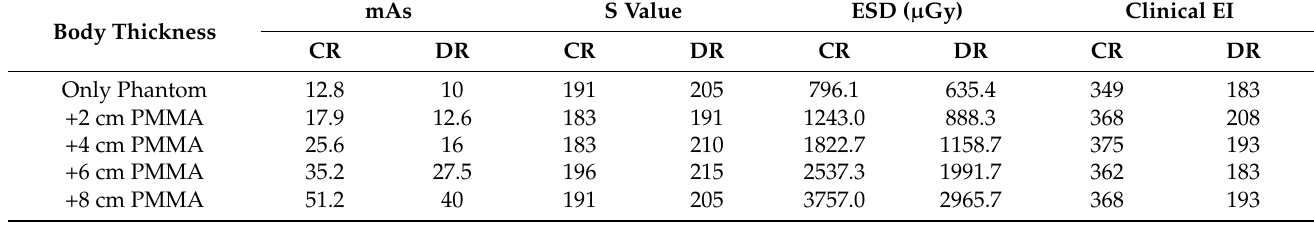
Figure 5. Relationship between phantom thickness and entrance surface dose: ( a ) Chest PA; ( b ) Chest LAT.